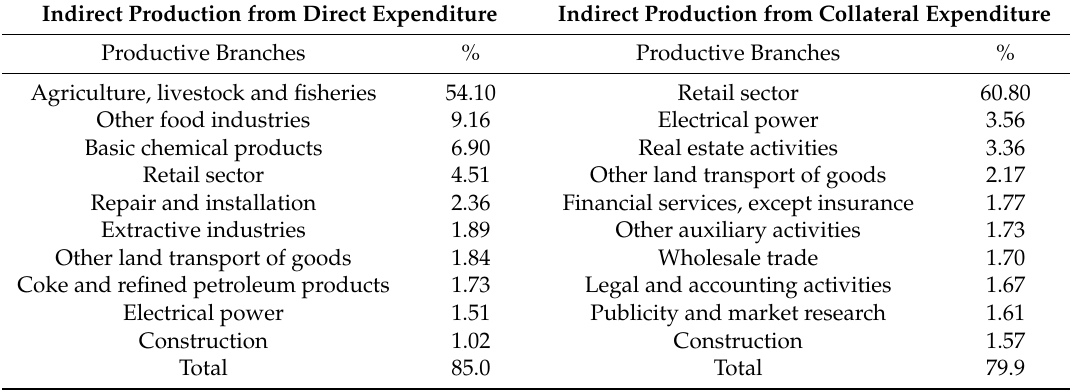
Table 6. Indirect production in the different productive branches (% of the